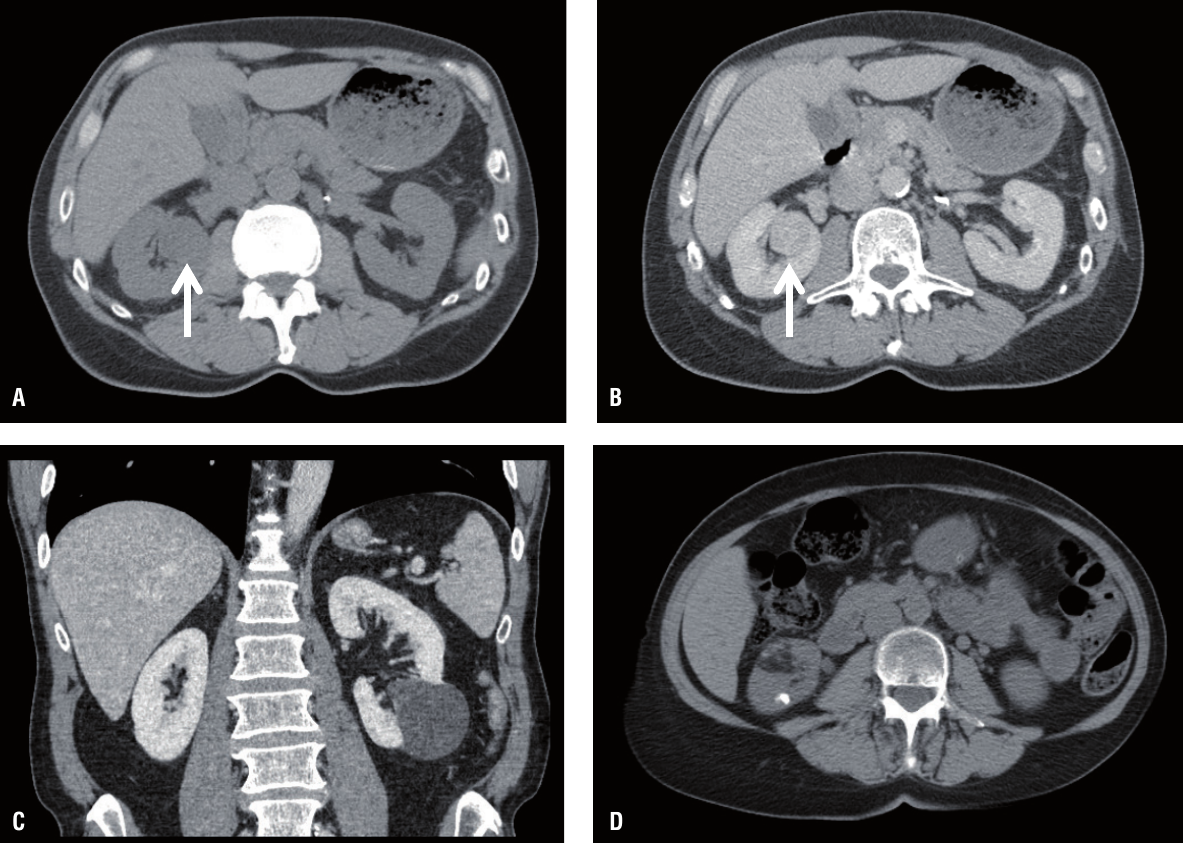
figure 1 - Exemplary CT scans of renal masses under active surveillance. a & b: solid enhancing renal mass (indicated by arrows), c: complex cystic mass, d: